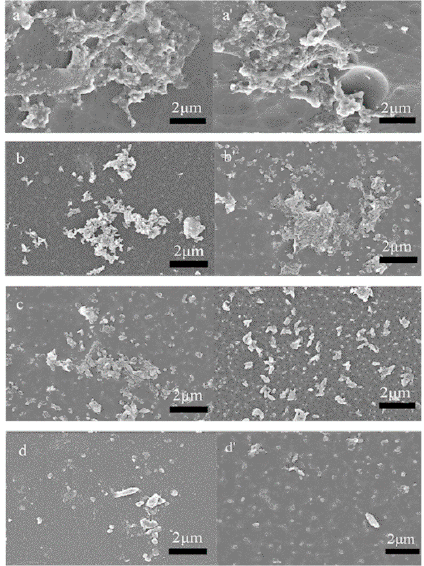
Figure 12. SEM images of PEI3a–PEI3d ′ after 8 weeks of degradation in buffer (( a ) = PEI3a; ( a ′ ) = Figure12. SEMimagesofPEI3a–PEI3d (cid:48) after8weeksofdegradationinbu ff er(( a ) = PEI3a; ( a (cid:48) ) = PEI3a (cid:48) ; PEI3a ′ ; ( b ) = PEI3b; ( b ′ ) = PEI3b ′ ; ( c ) = PEI3c; ( c ′ ) = PEI3c ′ ; ( d ) = PEI3d; ( d ′ ) = PEI3d ′ ). ( b ) = PEI3b; ( b (cid:48) ) = PEI3b (cid:48) ; ( c ) = PEI3c; ( c (cid:48) ) = PEI3c (cid:48) ; ( d ) = PEI3d; ( d (cid:48) ) = PEI3d (cid:48)